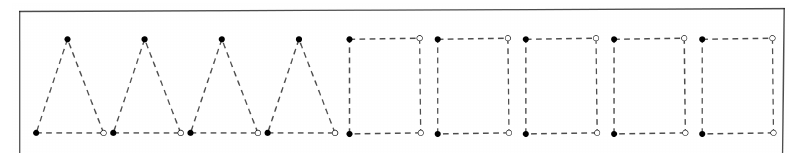
Figure 4. H 32 = 4 B 3 + 5 B 4 with its nr